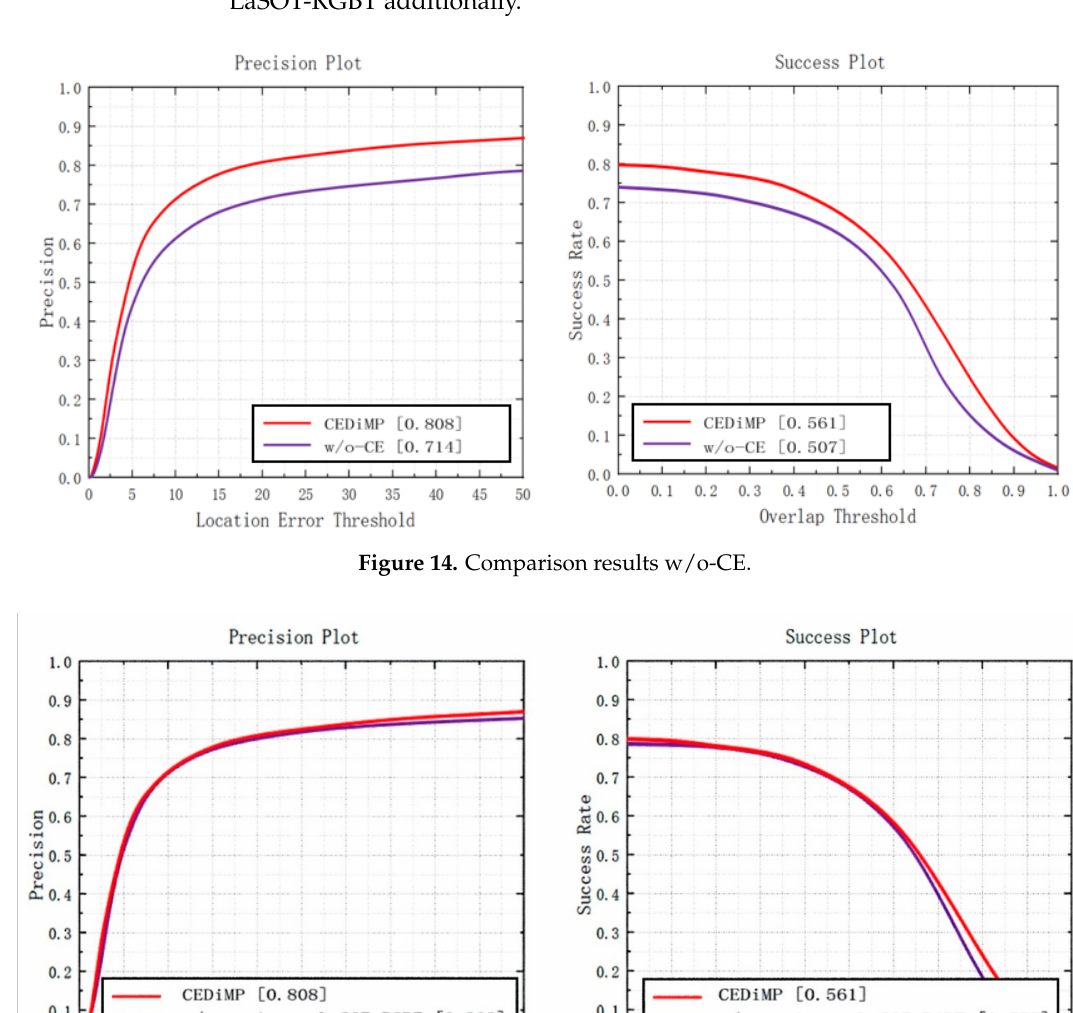
Figure 13. Single/dual-modal experiments results.